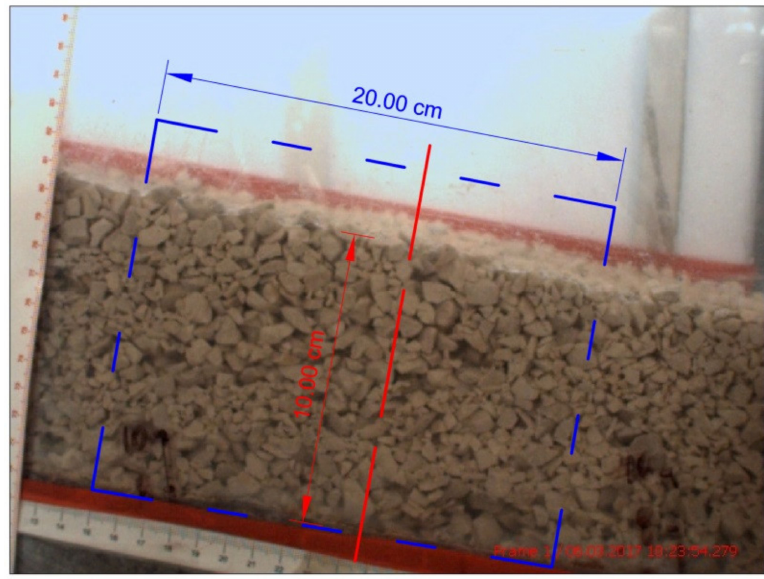
Figure 3. Scheme of the investigated area (in